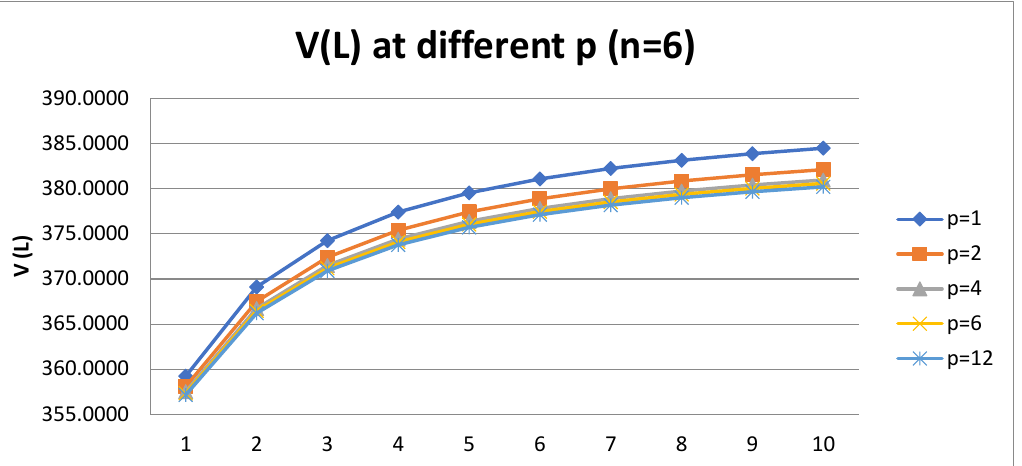
Figure 8. The dependence of the company value ( V ) on the leverage level ( L ) of a six-year-old company for advance profit tax payments with frequencies of p = 1, 2, 4, 6 and 12. As can be seen from Figure 9, the equity cost ( ke ) depended on the leverage level ( L ) in a linear manner. It decreased for annual ( p = 1), semi-annual ( p = 2) and quarterly ( p = 4) payments and increased for monthly ( p = 12) and bi-monthly payments ( p = 6). The eco- nomically justified amount of dividends was equal to the equity cost; therefore, the de- crease in the equity cost with the leverage level signaled the discovery of a new effect that could significantly change the dividend policy of the company. Note that for the three-year-old company, ke increased with L for monthly ( p = 12) and bi-monthly pay- ments ( p = 6) and the transition from decreasing to increasing behavior occurred at p = 4.